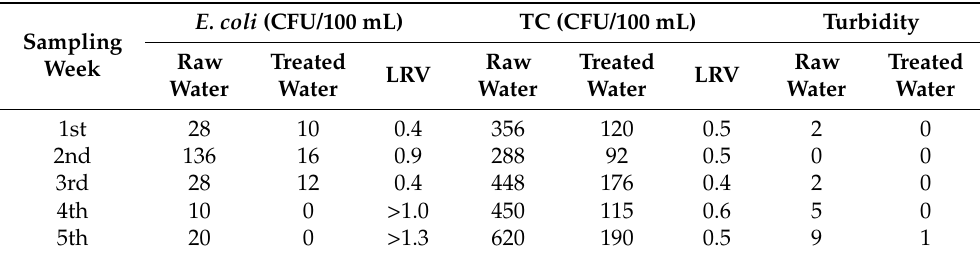
Table 3. Concentration of E. coli and TC and LRV in microfiltration system.